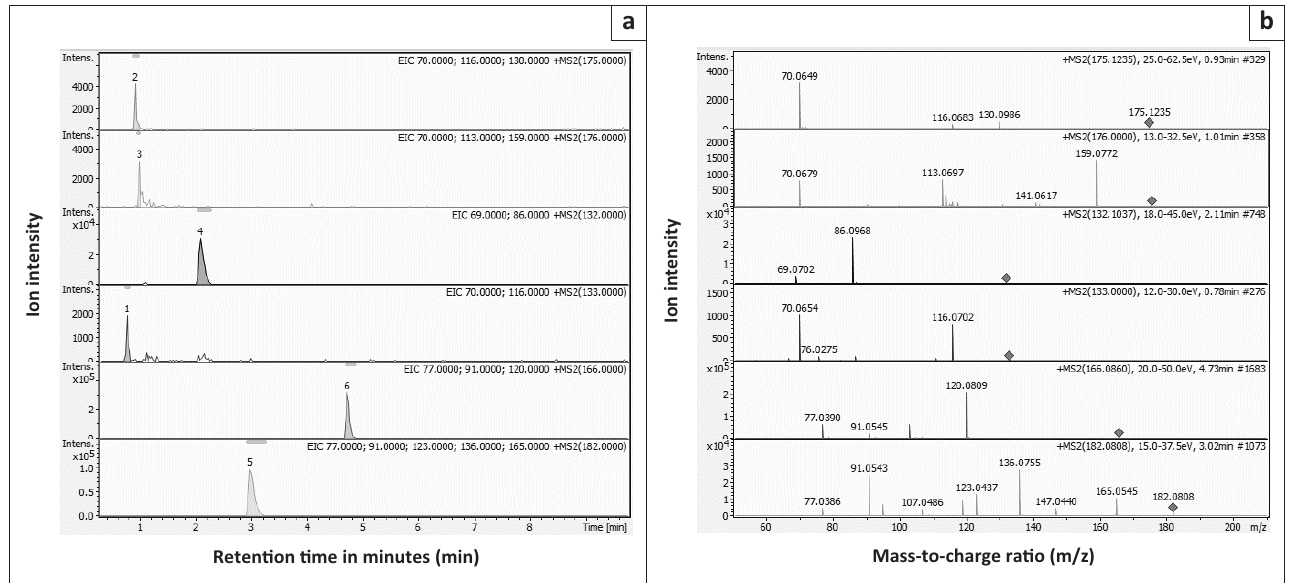
FIGURE 1 : Chromatogram showing (a) the UHPLC baseline separation of arginine, citrulline, isoleucine, ornithine, phenylalanine and tyrosine; and (b) the mass spectrum with retention times and collision energy required to fragment each amino acid to give the fragment ions (quant masses). Data analysed between November 2019 and January 2021, Johannesburg, South TABLE 1: Analytical method performance characteristics of three spiked blank matrices with amino acid standards at different concentrations, Johannesburg, South Africa, November 2019 to January 2021. Target analyte